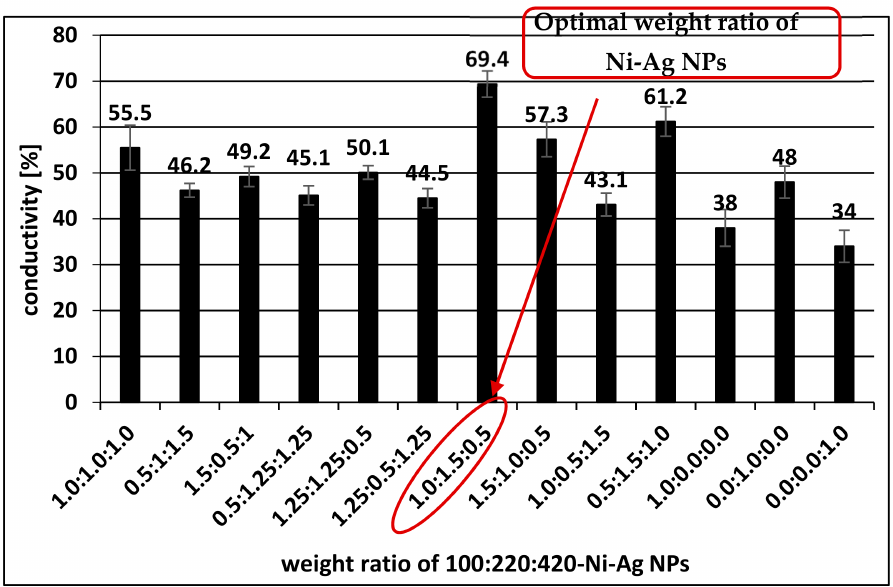
Figure 10. The dependence of the conductivity compared to the bulk nickel for metallic films formed with a mixture of Ni-Ag NPs with different size distributions on their weight ratio after sintering at optimal conditions (300 ◦ C, 30 min).